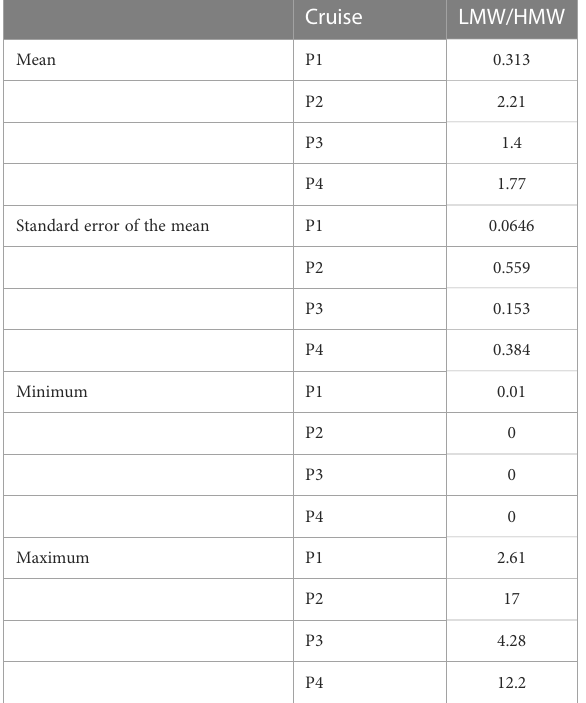
TABLE 4 LMW/HMW ratios for all four Perdido cruises.